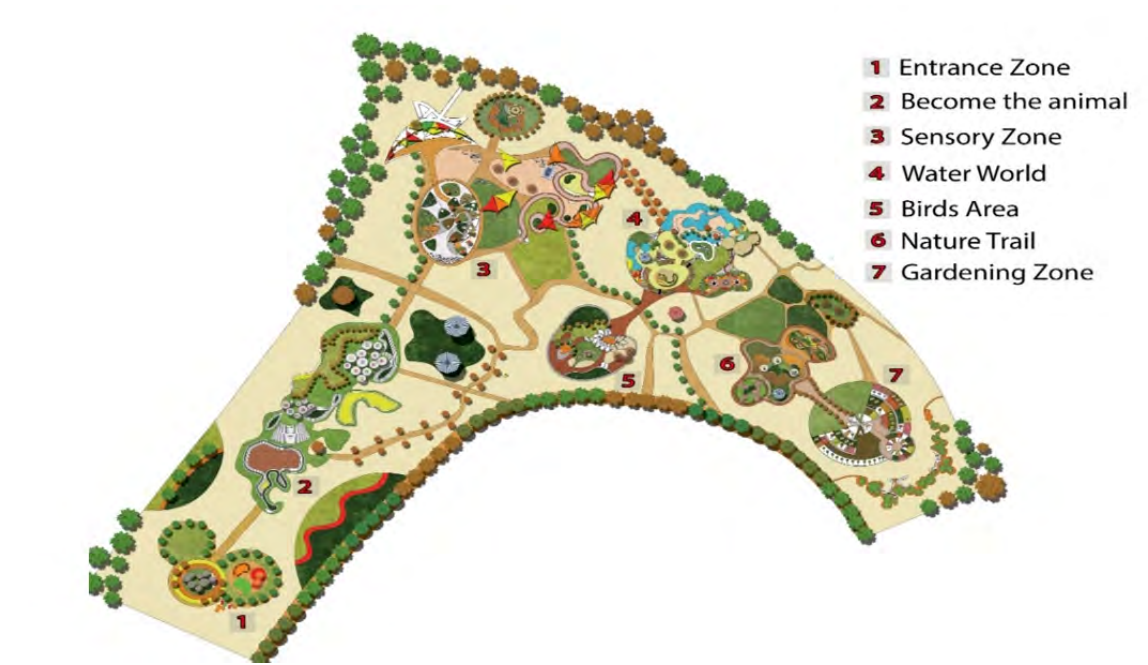
Figure 5. The site plan of sensory